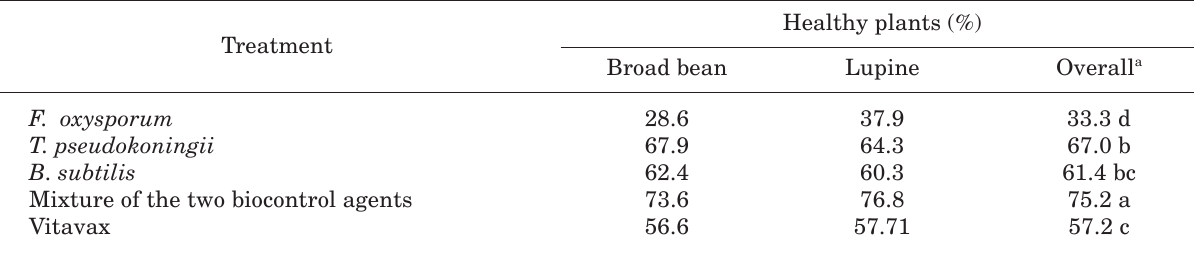
Table 2. Field assessment of the effectiveness of biocontrol agents in controlling Fusarium oxysporum causing wilt of broad bean and lupine, expressed as a percentage of healthy plants.